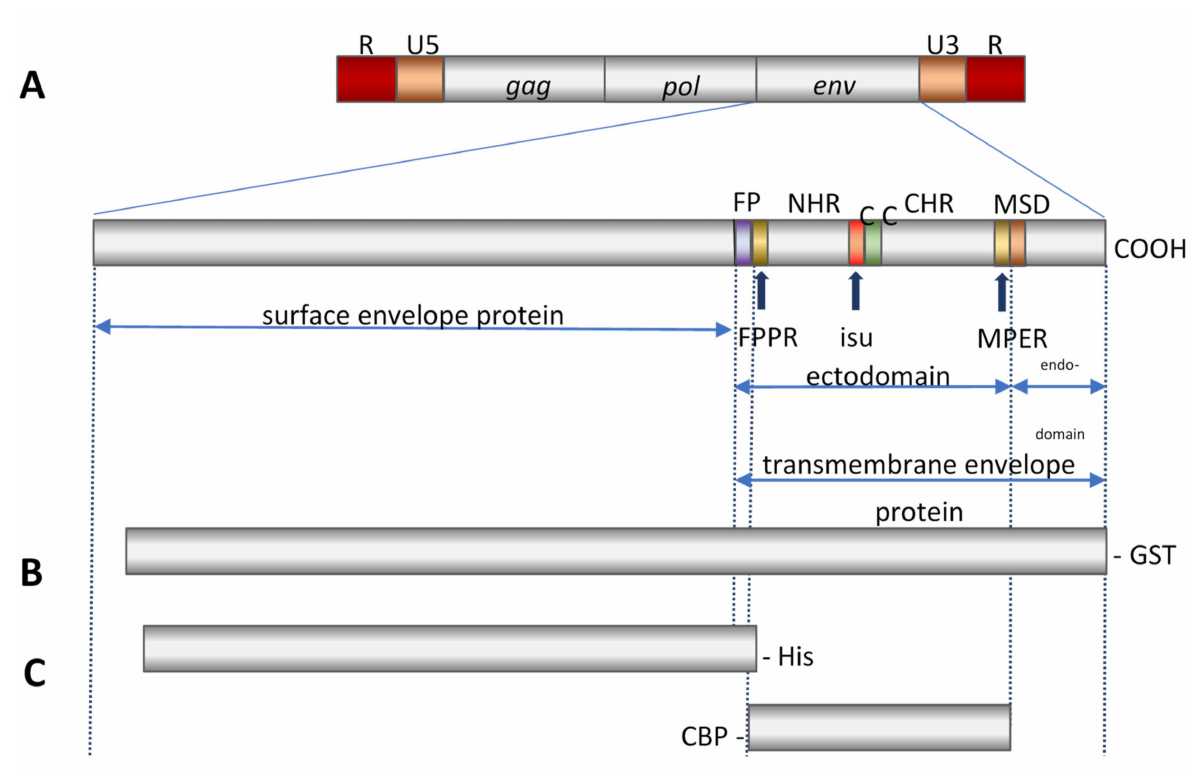
Figure 1. ( A ), Schematic presentation of the genome of the KoRV (R, repetitive sequence; U5, unique 5 (cid:48) sequence; gag, group-specific antigen; pol, polymerase; env, envelope). In the transmembrane envelope protein, well characterized functional domains are indicated: FP, fusion peptide, FPPR, fusion peptide proximal region; NHR, N-terminal helical region; isu, immunosuppressive domain; C, cysteine; C-C, Cys-Cys loop; CHR, C-terminal helical region; MPER, membrane proximal external region; MSD, membrane spanning domain. ( B ), Recombinant precursor envelope protein fused to GST used by Olagoke et al. [33–35] for immunization, GST, glutathione S-transferase. ( C ), Recombinant proteins used by Fiebig et al. [36,37] for immunization, top: His-tag labeled surface envelope protein, bottom: ectodomain of the transmembrane envelope protein fused to CBP, CBP, calmodulin binding